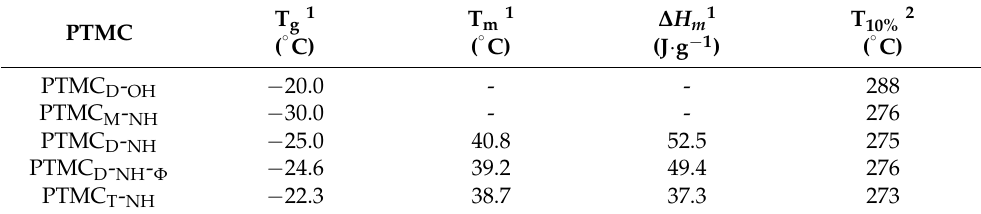
Table 2. Thermal properties of various alcohol and amine initiated PTMC ( DP n = 100).